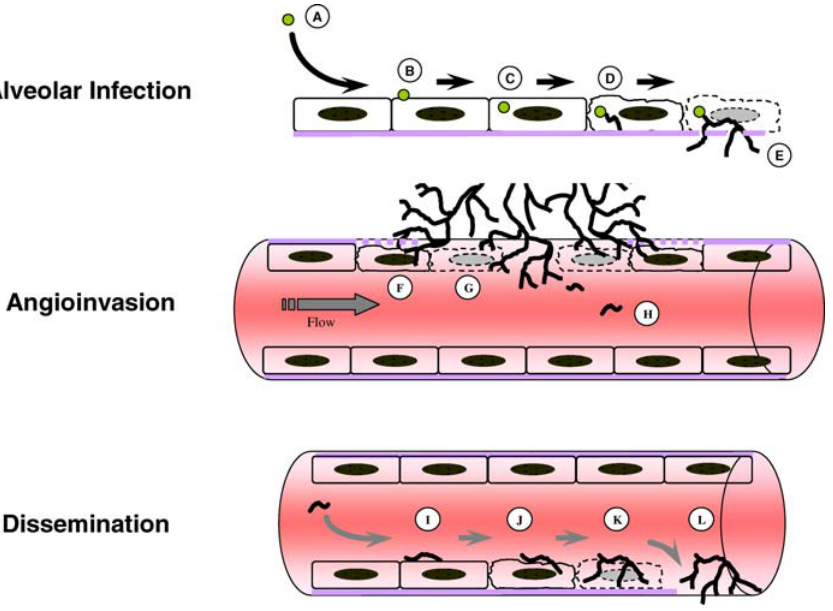
Figure 1. Model of Aspergillus fumigatus Interactions with Pulmonary Epithelial Cells and Vascular Endothelial Cells during Angioinvasion and Dissemination Invasive aspergillosis occurs via the following steps: infection is initiated by the inhalation of small numbers of airborne conidia (A), which adhere to pulmonary epithelial cells (B), and are rapidly endocytosed (C). Within the epithelial cells, the conidia germinate to form hyphae (D), which grow by apical extension and escape from the epithelial cells (E). Next, emergent hyphae penetrate the abluminal surface of endothelial cells (F) and induce endothelial cell damage (G). Hyphal fragments disseminate hematogenously (H) and adhere to the luminal endothelial cell surface (I) before invading these cells (J). Luminal invasion results in endothelial cell damage (K) and extravascular invasion of deep organs (L). Steps (A–E) occur in the pulmonary alveoli, (F–H) in the pulmonary blood vessels, and (I–L) in the systemic blood